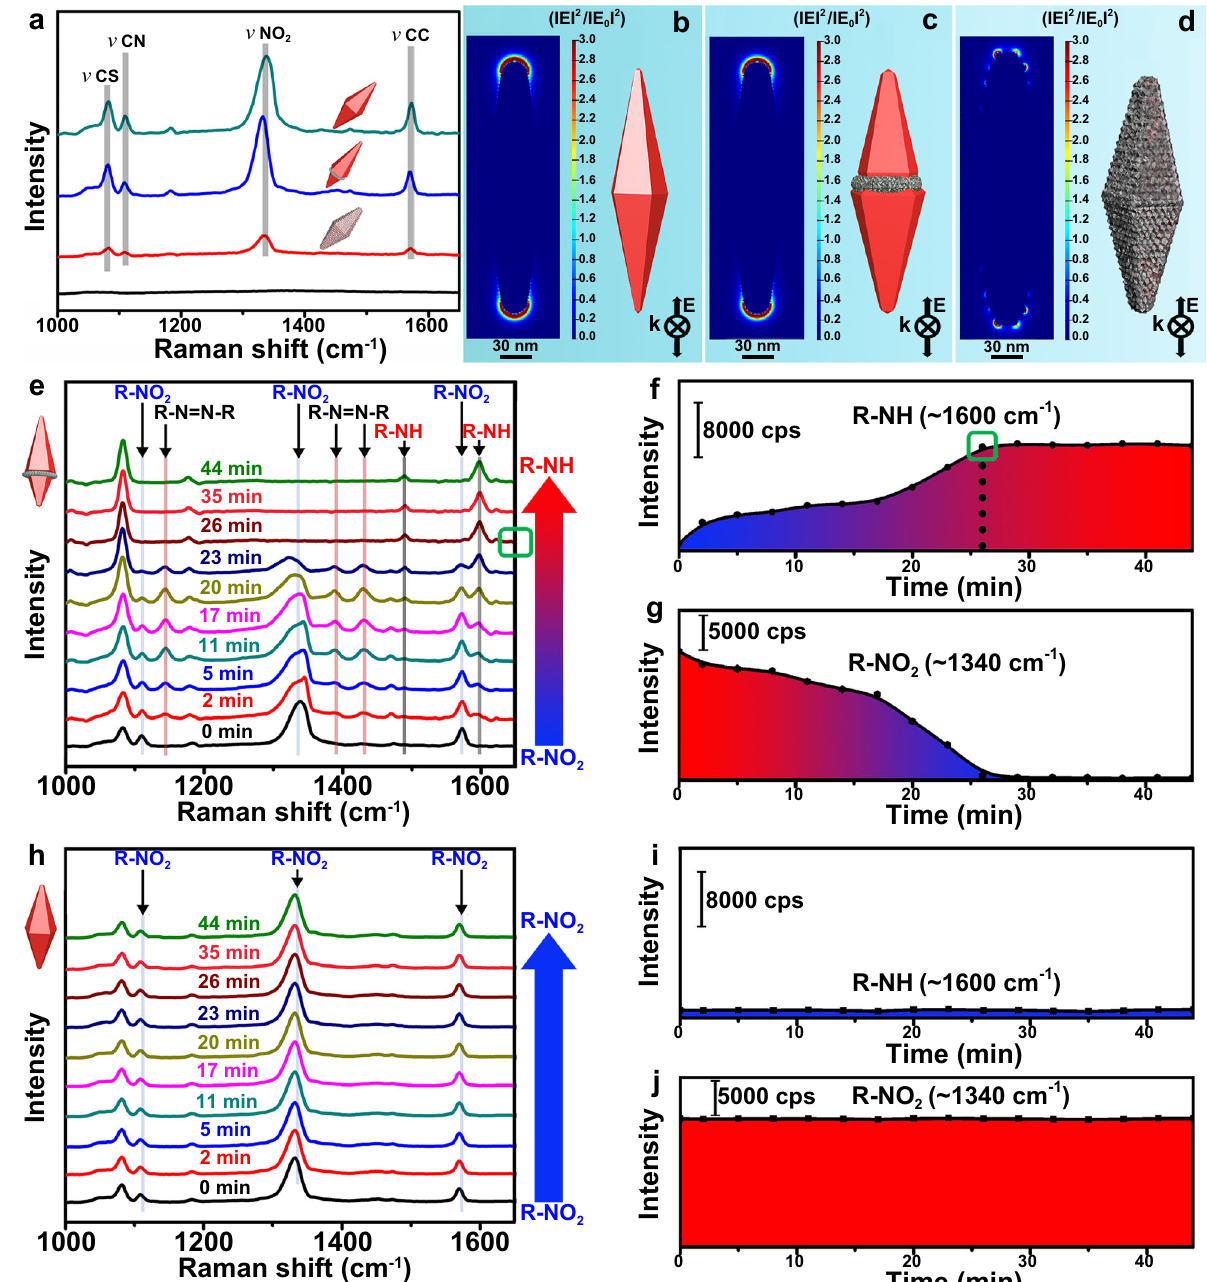
Fig. 9 Optical properties and in situ monitoring organic reaction with SERS. a Raman spectra recorded on AuNB@PtNC (longitudinal length: 236 nm. Transverse length: 72 nm), AuNB (longitudinal length: 230 nm. Transverse length: 70 nm) and (AuNB-core)@(Pt-shell) nanocrystals. b , c , d Electrical fi eld enhancement on the surface of various nanocrystals. Raman spectra, peak intensity of R-NO 2 at 1340 cm − 1 and peak intensity at 1600 cm − 1 with time when using e , f , g AuNB@PtNC nanocrystals and h , i , j AuNBs as catalysts. In all schematics, the red and gray colors represent Au and Pt, respectively. Source data are provided as a Source Data fi